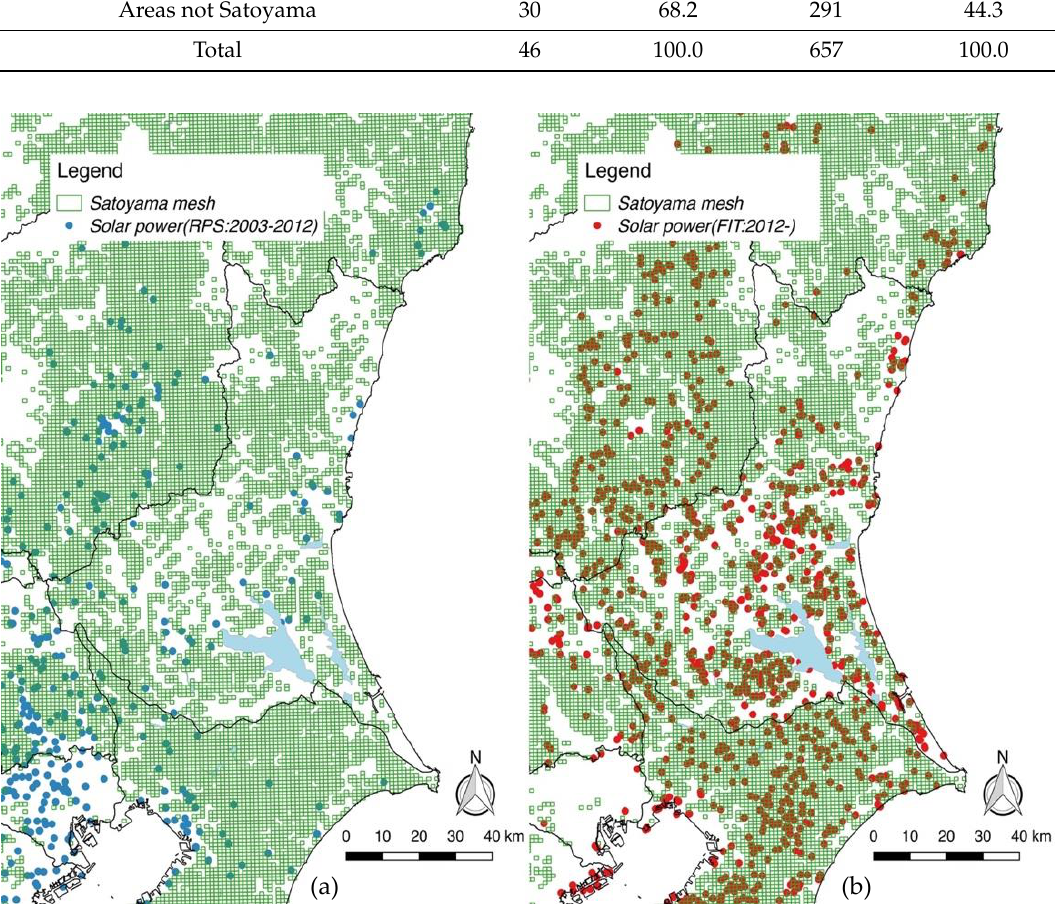
Figure 6. Location of the solar power installations in 2014 by RPS ( a ) and 2017 by FIT ( b ). Source: Collected and processed by the authors.